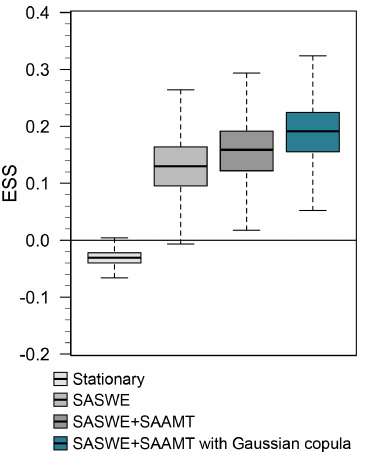
Figure 8. Energy skill score (ESS) distribution for four different BHM versions for a 0-month lead time for the calibration period (1965–2018). Higher values of the ESS indicate better model per- formance. The whiskers show the 95% credible intervals, boxes show the interquartile range, and horizontal lines inside the boxes show the median. Outliers are not displayed. The light gray box de- notes a stationary model, the gray box a nonstationary model with SASWE as a covariate, the dark gray box a nonstationary model with SASWE and SAAMT as covariates, and the dark turquoise model adds a Gaussian copula to model spatial